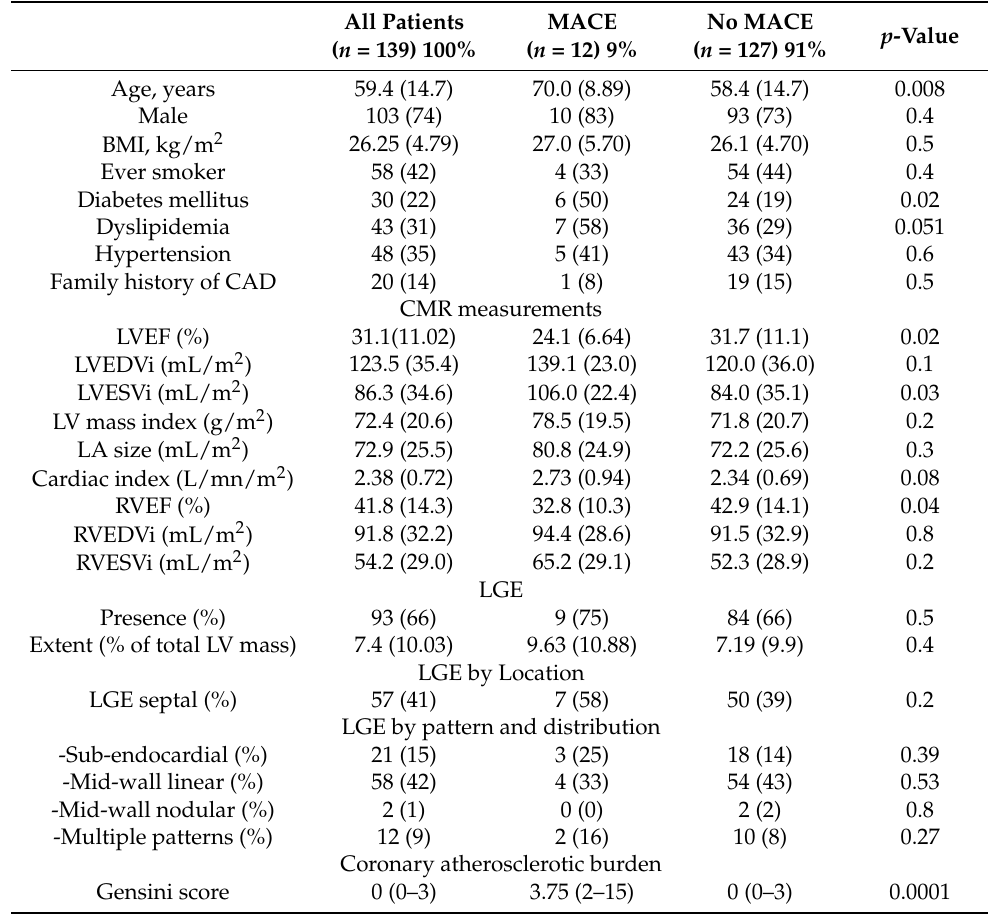
Table 1. Baseline